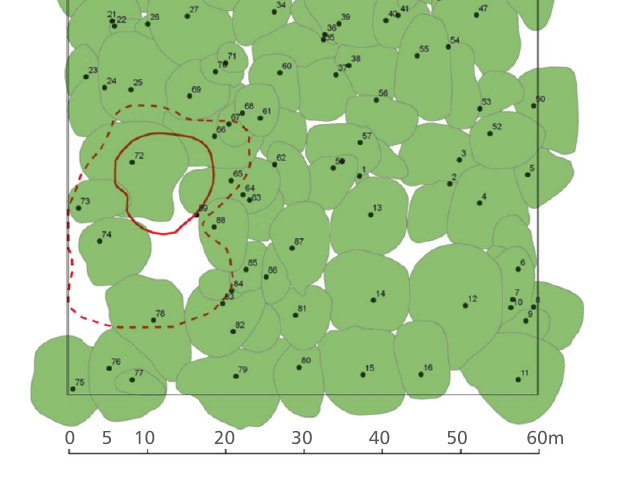
FIGURE 4. Relationship of the crown projection area (CPA) and the